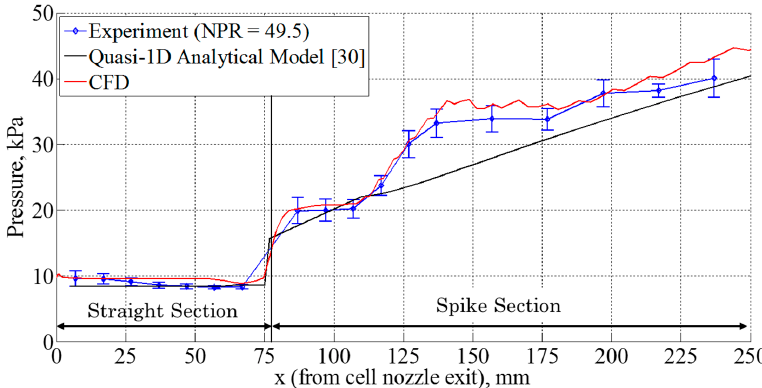
Figure 10. Comparison of the spike wall pressure distribution among experiment, analytical model, and CFD. The NPR was 49.5 and the external flow Mach number was 2.0.